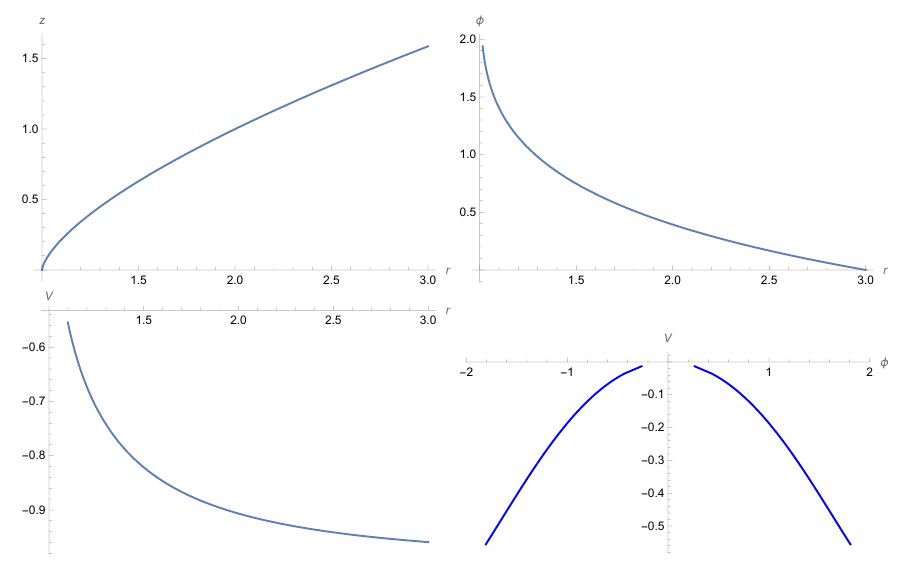
Figure 17 . The profile of z ( r ) = ( r − 1) 2 / 3 . In this way, when the series expansion of the inverse function r ( z ) contains non-integer power term, the conformal dimension can be ∆ 6 = 1 / 2